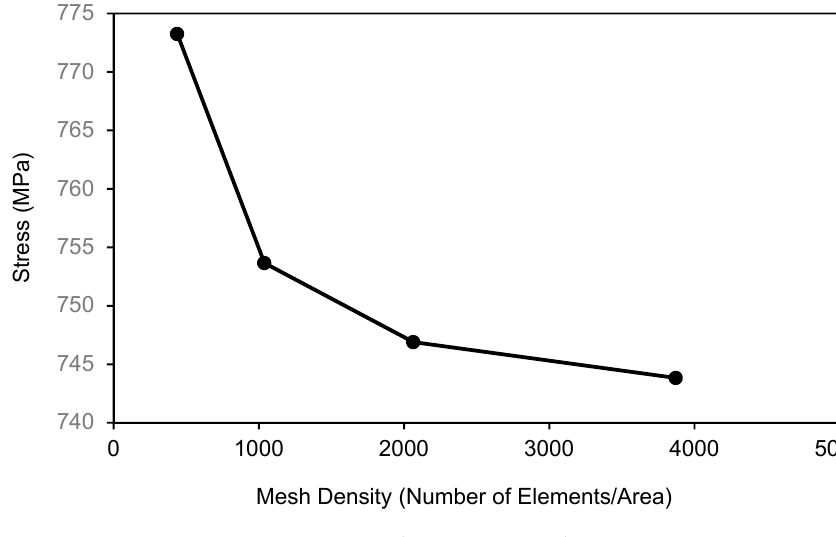
Figure 5. Mesh sensitivity analysis .